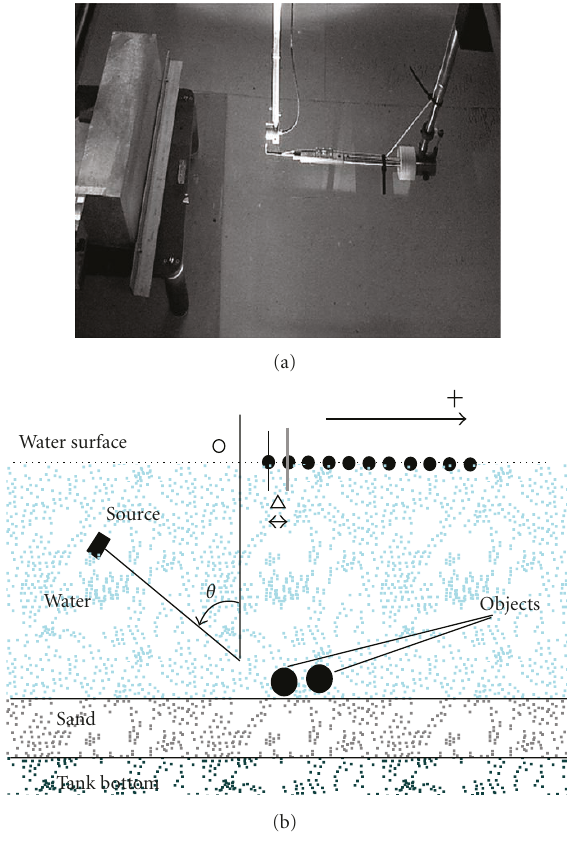
Figure 14: The experiment.